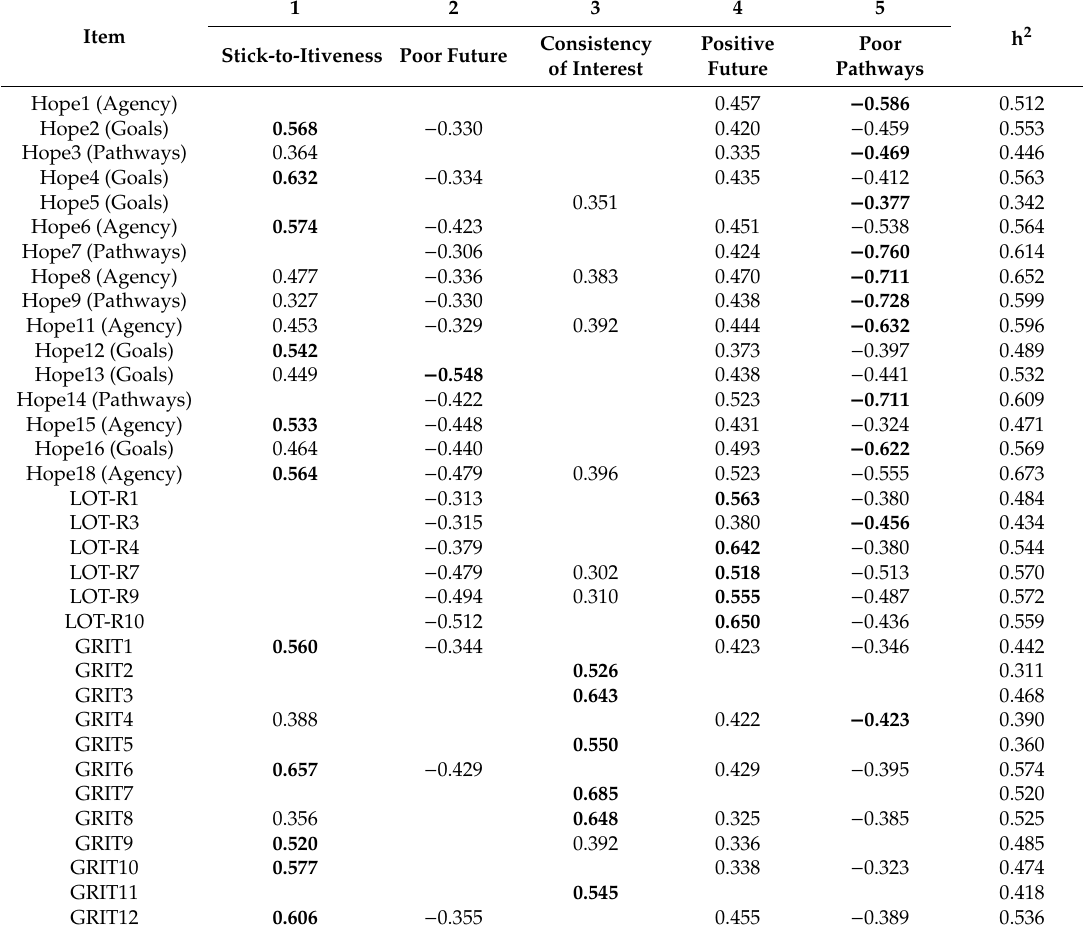
Table 3. Factor Loadings and Communalities from a PAF with Oblimin Rotation and Five-Factor Solution for 54